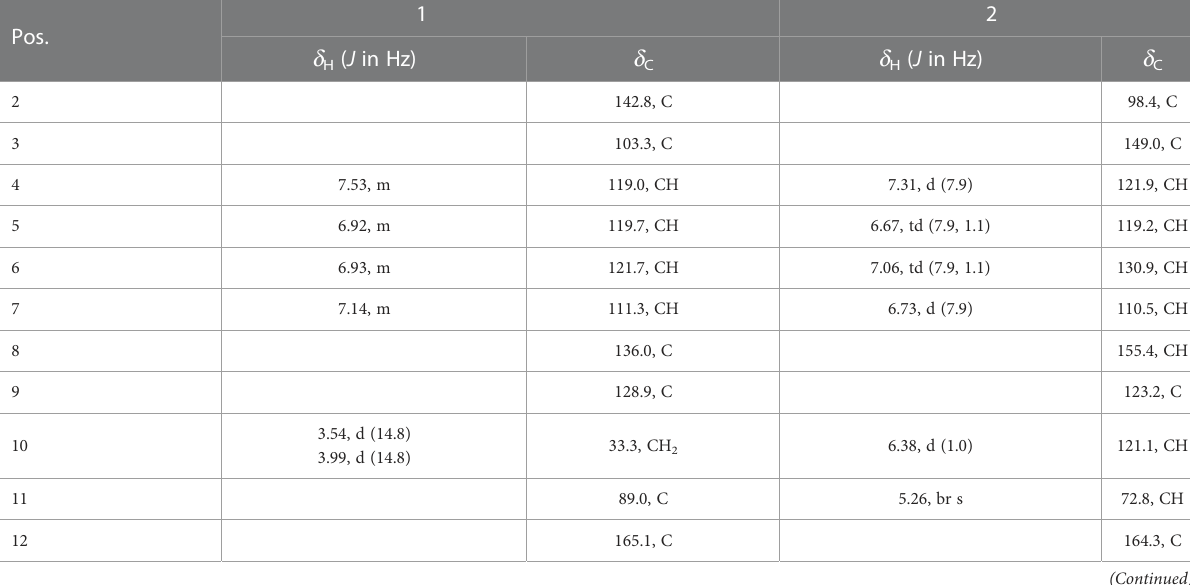
TABLE 1 ｜ 1 H NMR (500 MHz) and 13 C NMR (125 MHz) data for 1 and 2 in acetone- d 6. .